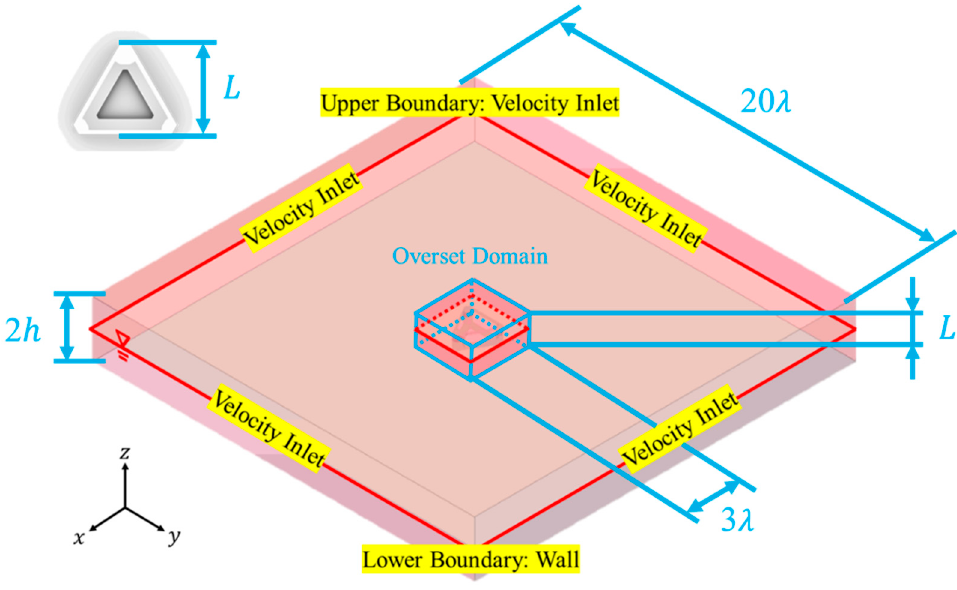
Figure A3. Computational domain of viscous-flow modeling.